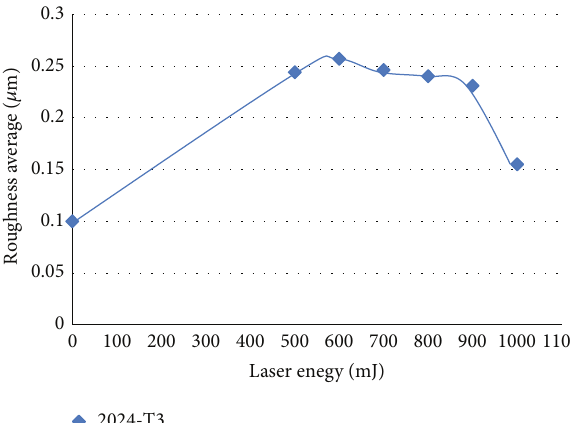
Figure 6: Surface roughness of treated region with different laser pulse